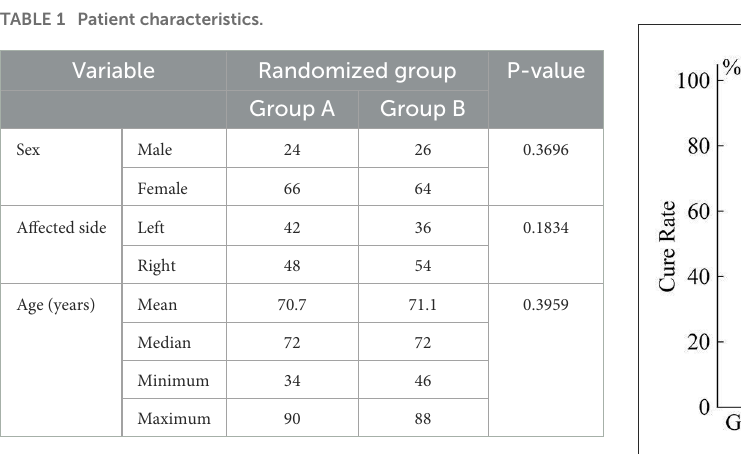
FIGURE3 Cure rate for positional nystagmus in patients with pc-BPPV 1 week after treatment. The bar chart shows that there was no significant difference in cure rate between Groups A and B. The probability distribution of the difference is shown in the graph on the right. The gray area represents 5% of the total area and indicates that the upper limit of the 95% confidence interval is